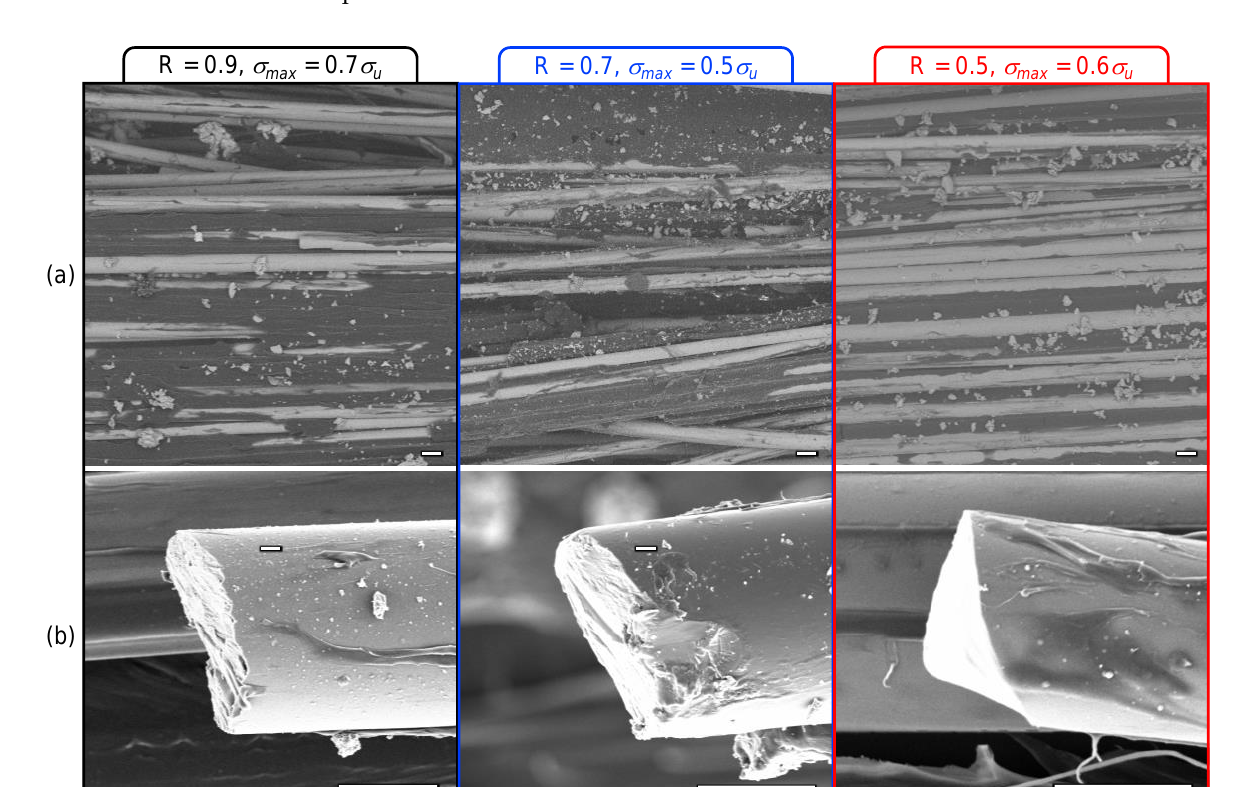
Figure 7. ( a ) Micrographs of fatigue run-out specimens showing more resin damage at lower R values and ( b ) fracture surfaces of individual fibers ( scale bars are 10 μm ) .